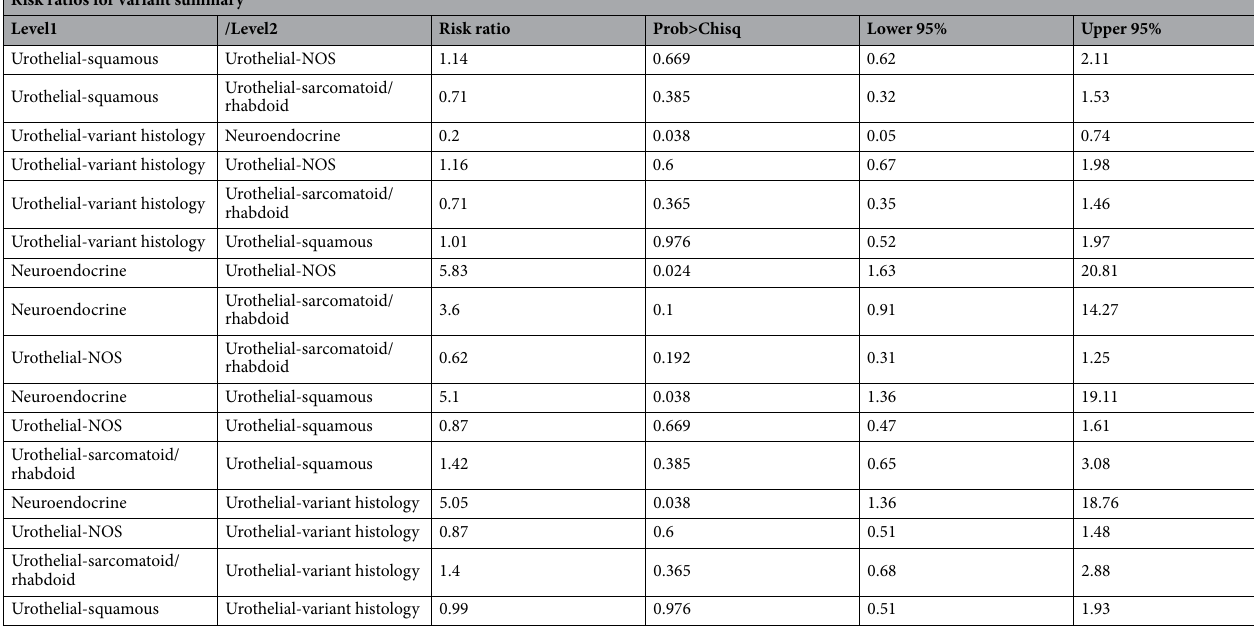
Table 3. Multivariate analysis for